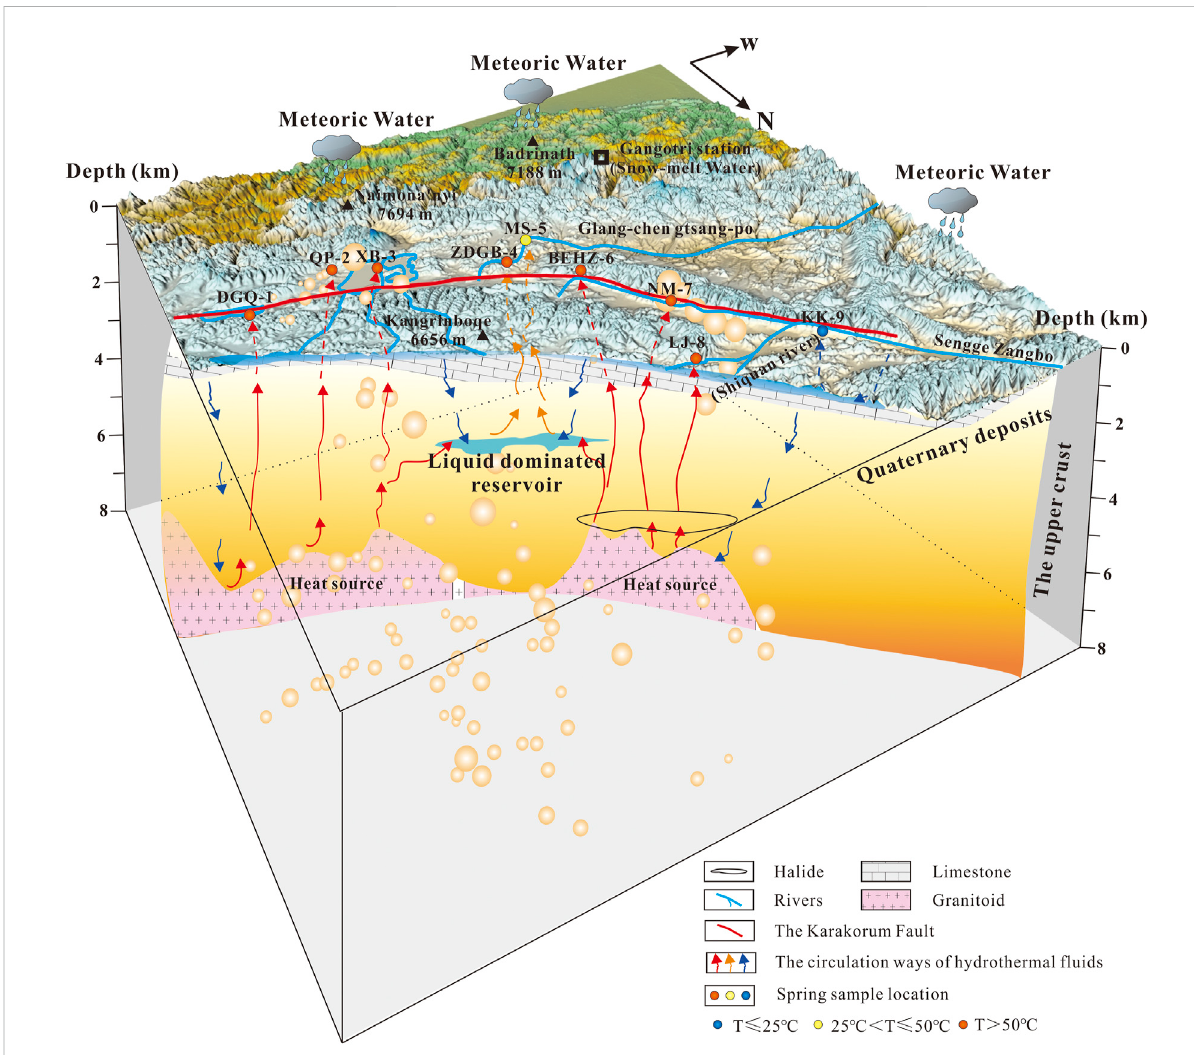
FIGURE 10 Conceptual hydrothermal model of the hydrogeochemical cycling process in high-temperature geothermal systems along the KKF. The red line and blue lines represent the main fault and rivers of the KKF, respectively. The blue, yellow, and red arrows represent the circulation pathways of hydrothermal fl uidswithlow,intermediate,andhightemperatures,respectively.Theorangesphereshowstheearthquakesthathaveoccurredalong the KKF within 200 km since 1970, and its dimensions (0.8 – 4.4 mm) correspond to the magnitude of the earthquake (M L 1.0 –